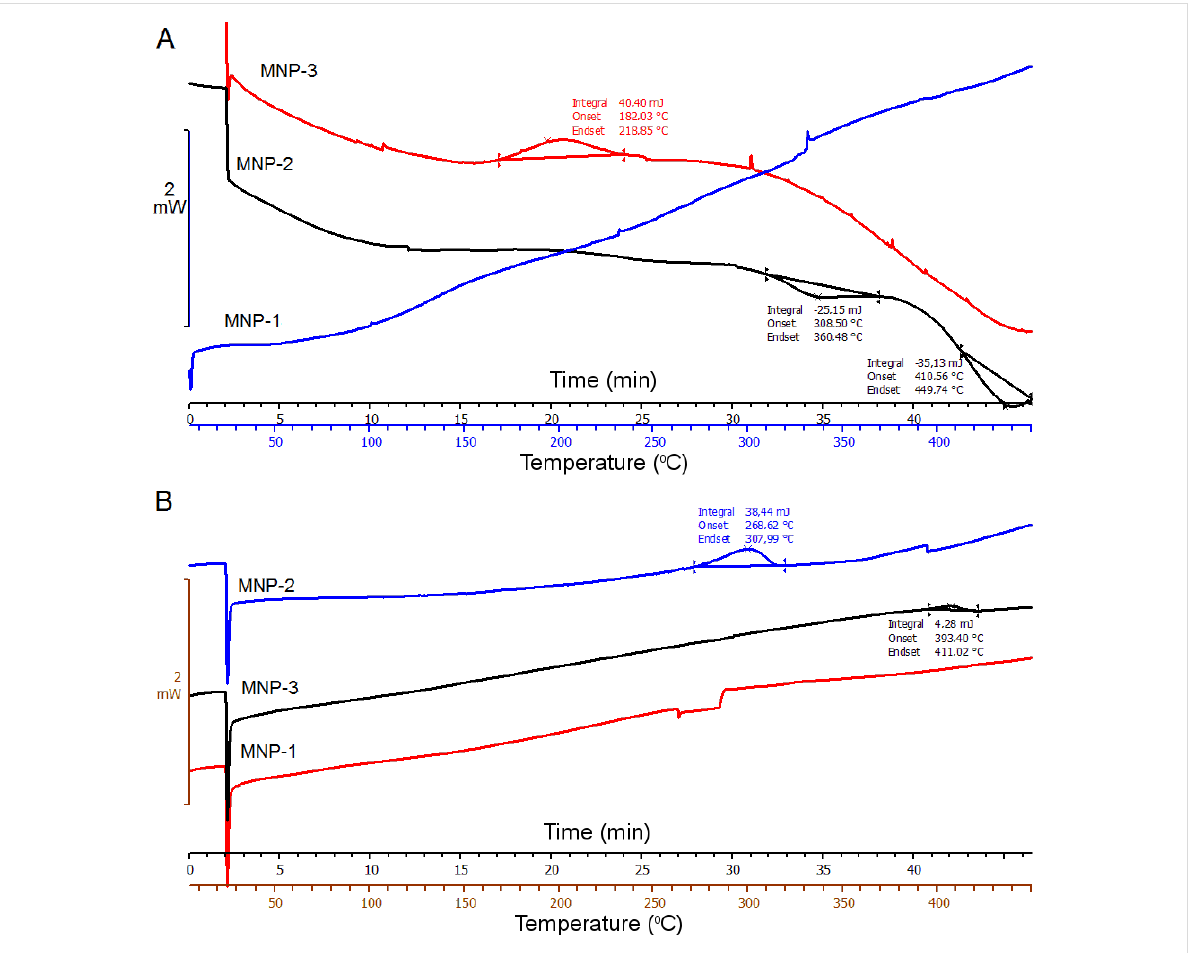
Figure 6: DSC curves of reference nanoparticles before heating (A) and after heating at 500 °C (B).